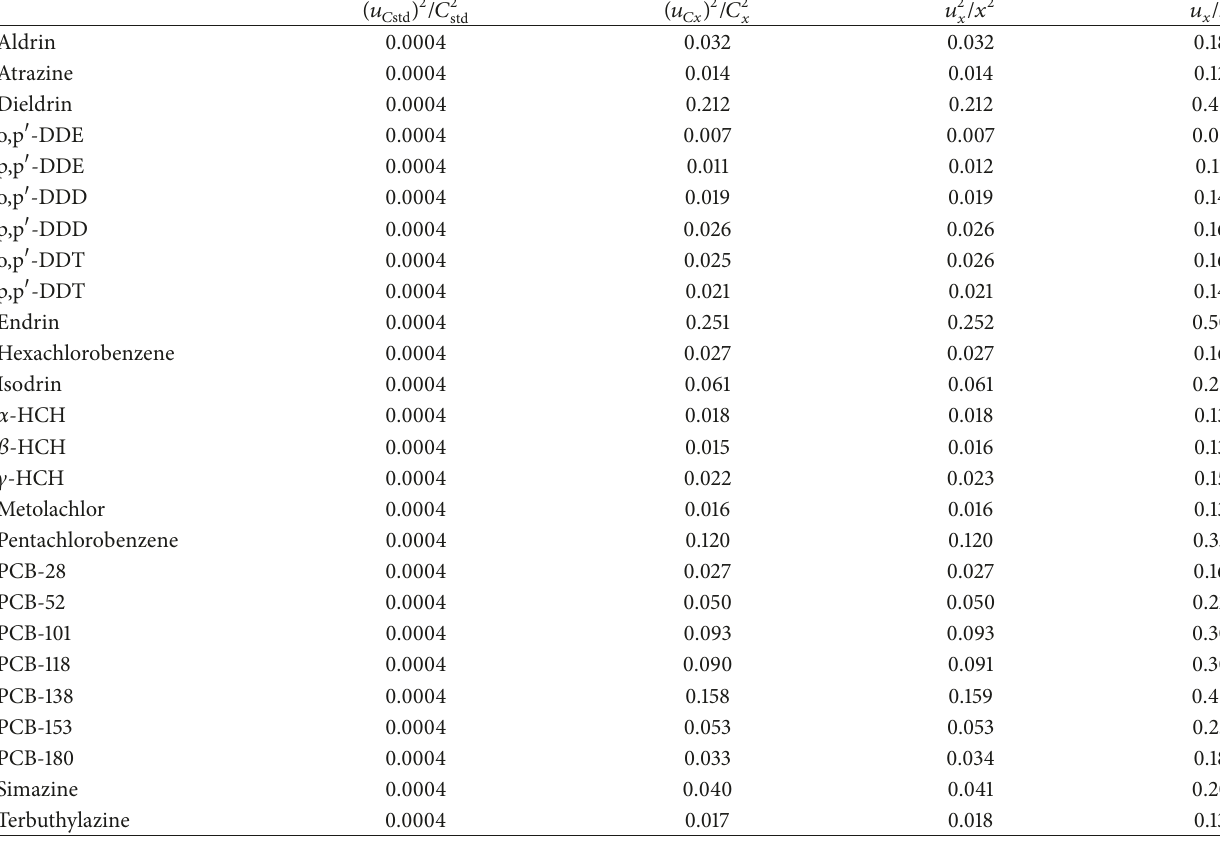
Table 4: Uncertainty associated with concentration measured through calibration.